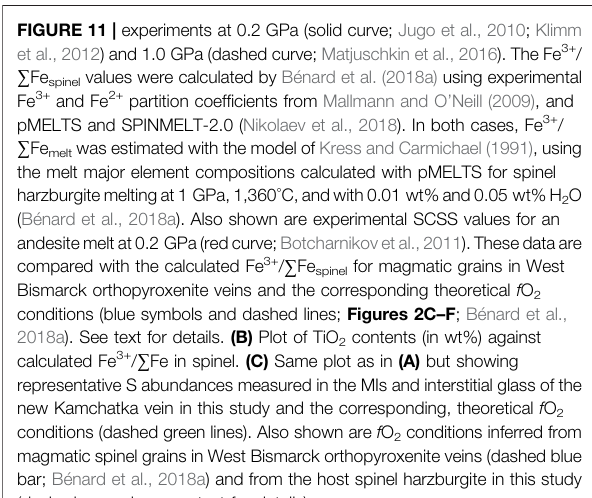
FIGURE 11 | experiments at 0.2 GPa (solid curve; Jugo et al., 2010; Klimm et al., 2012) and 1.0 GPa (dashed curve; Matjuschkin et al., 2016). The Fe 3+ / (cid:1) Fe spinel values were calculated by Bénard et al. (2018a) using experimental Fe 3+ and Fe 2+ partition coef fi cients from Mallmann and O ’ Neill (2009), and pMELTS and SPINMELT-2.0 (Nikolaev et al., 2018). In both cases, Fe 3+ / (cid:1) Fe melt was estimated with the model of Kress and Carmichael (1991), using the melt major element compositions calculated with pMELTS for spinel harzburgitemeltingat1 GPa,1,360 ° C,andwith0.01 wt%and0.05 wt%H 2 O (Bénard et al., 2018a). Also shown are experimental SCSS values for an andesitemeltat0.2 GPa(redcurve;Botcharnikovetal.,2011).Thesedataare compared with the calculated Fe 3+ / (cid:1) Fe spinel for magmatic grains in West Bismarck orthopyroxenite veins and the corresponding theoretical f O 2 conditions (blue symbols and dashed lines; Figures 2C – F ; Bénard et al., 2018a). See text for details. (B) Plot of TiO 2 contents (in wt%) against calculated Fe 3+ / (cid:1) Fe in spinel. (C) Same plot as in (A) but showing representative S abundances measured in the MIs and interstitial glass of the new Kamchatka vein in this study and the corresponding, theoretical f O 2 conditions (dashed green lines). Also shown are f O 2 conditions inferred from magmatic spinel grains in West Bismarck orthopyroxenite veins (dashed blue bar; Bénard et al., 2018a) and from the host spinel harzburgite in this study (dashed green bar; see text for